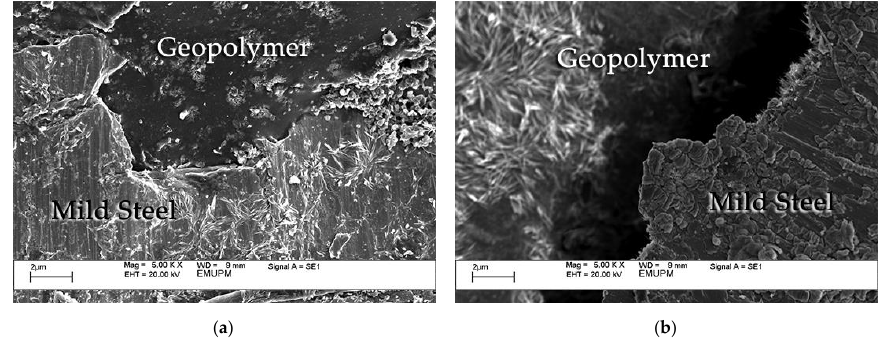
Figure 10. Cross-section SEM micrographs of ( a ) coated sample S17 and ( b ) coated sample S26.